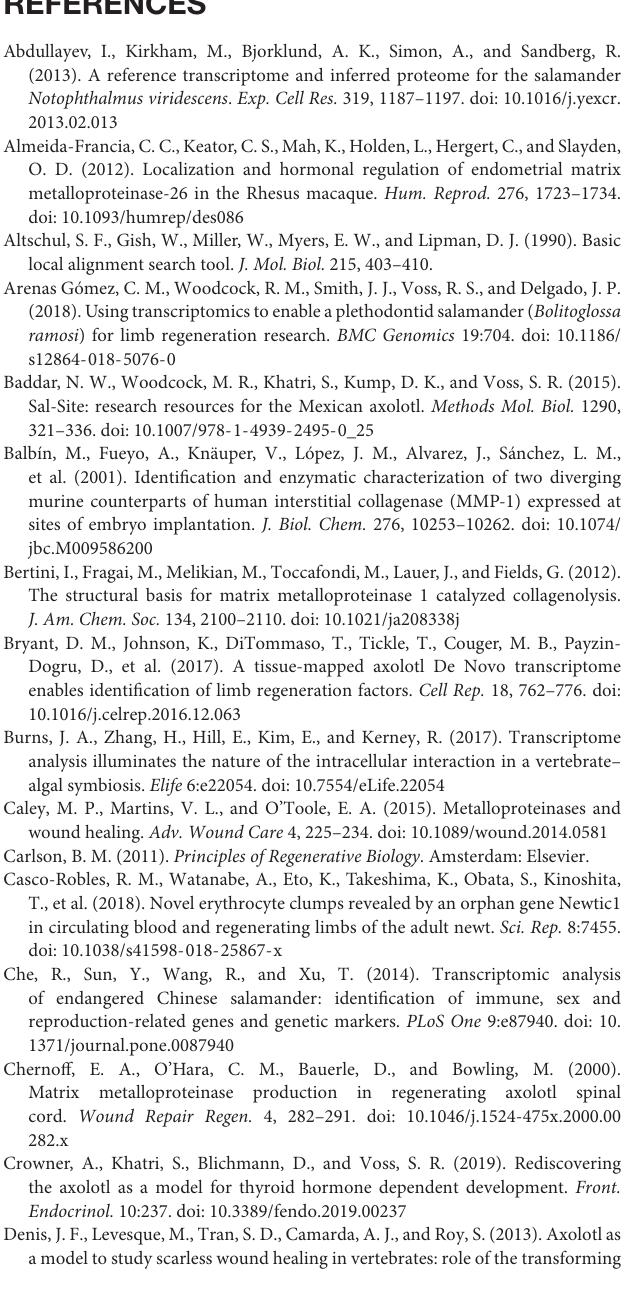
Supplementary File 9 | The hinge domain is dissimilar in length and sequence between stromelysins and collagenases. Supplementary File 10 | MMPe protein has salamander-specific insertions and sequence variation. Supplementary File 11 | Salamander-specific insertion in the catalytic domain of MMP16. Top: MMP16 main protein domain structure. Bottom: Multiple sequence alignment showing the salamander-specific insertion close to conserved Zn + 2 binding motif in the catalytic domain. Supplementary File 12 | Multiple sequence alignment of CCN proteins in human and